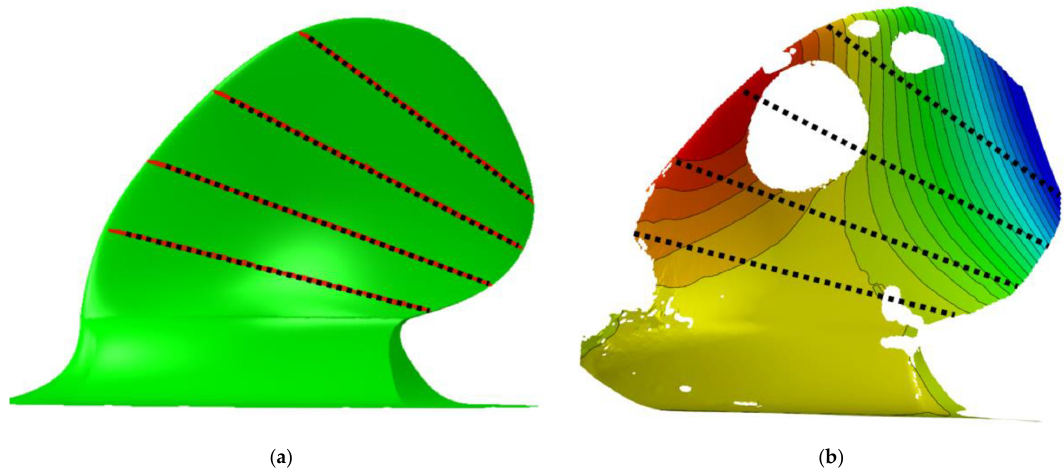
Figure 13. The displacements on the path lines from the blade’s trailing edge to the leading edge of the propeller blade were used to observe the quantifiable twist deformation characteristics, bend and twist unambiguously. ( a ) Analysis along a line in the FEA. ( b ) Analysis along a line in the DIC.